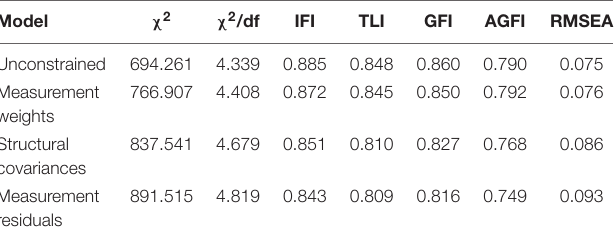
TABLE 5 | Analysis of fit between adolescent drug abusers and non-drug abusers.